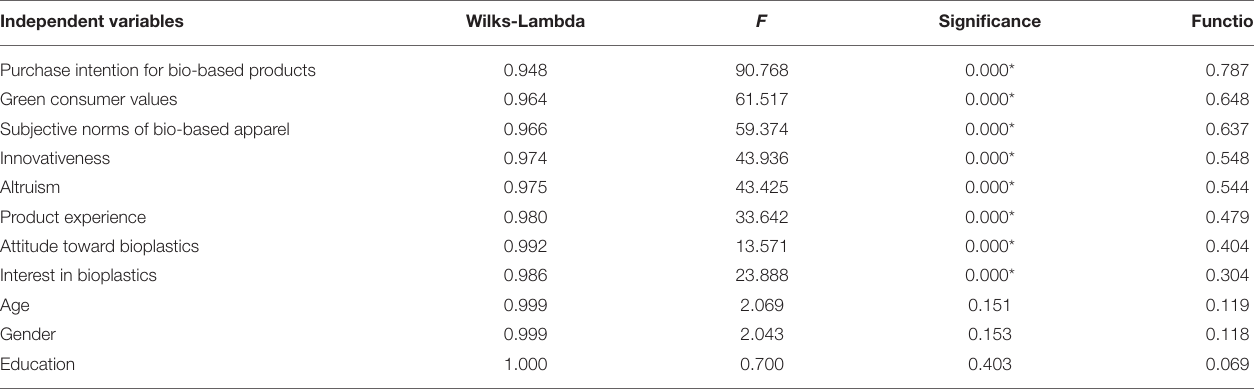
TABLE 6 | Structure matrix of discriminant